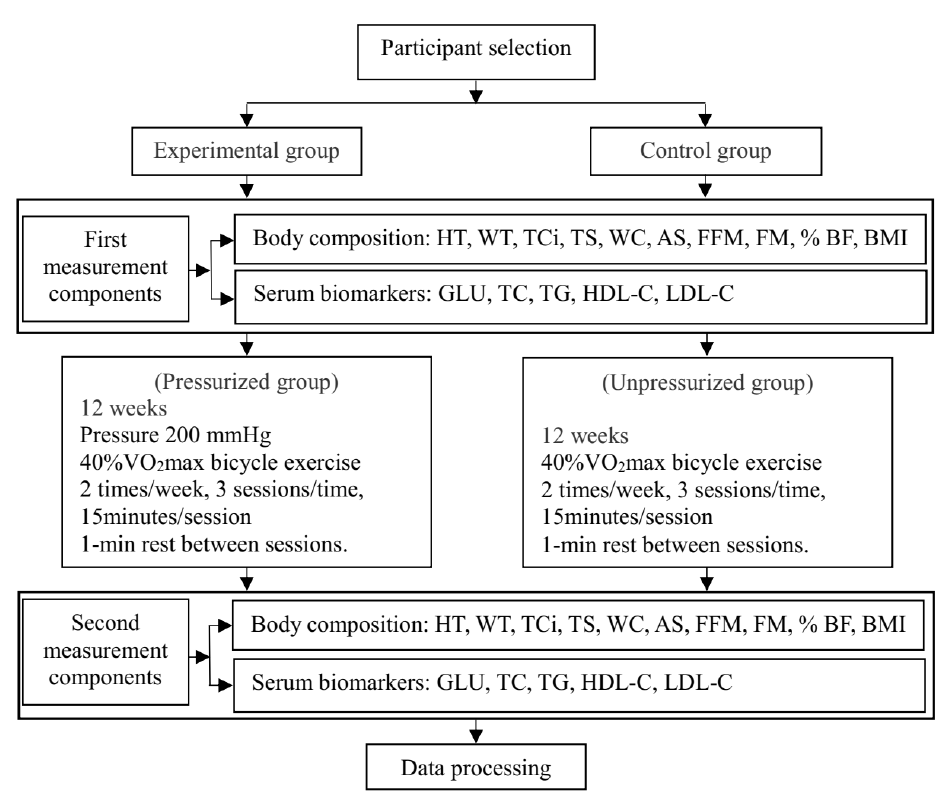
Figure 1. Study Procedures (HT, height; WT, weight; TCi, thigh circumference; TS, thigh skin fold thickness; WC, waist circumference; AS, abdominal skinfold thickness; FFM, fat-free mass, FM, fat mass; % BF, body fat percentage; BMI, body mass index; GLU, glucose; TC, Total cholesterol; TG, triglyceride; HDL-C, high-density lipoprotein cholesterol; LDL-C, Low-density lipoprotein choles- terol).